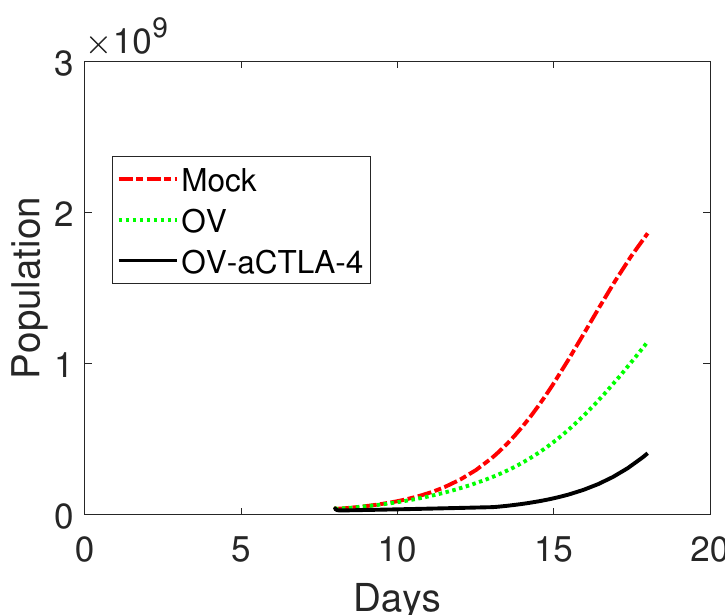
Figure 2. Comparison among numerically simulated dynamics of susceptible tumor cells for MOCK, OV, and OV-aCTLA-4 after treatments. The initial condition is ( 4 × 10 7 ,0,0,250,250,0,0,10 4 ) . The treatment is administered on day 8 as the tumor reaches an average volume of 4 × 10 7 cells and continues for 5 days. For OV only, the doses of oncolytic virus are s = 2 × 10 6 . The same amount of oncolytic virus is applied to OV-aCTLA-4 treatment with 0.76 blockade rate of CTLA-4. Other parameter values are listed in Table